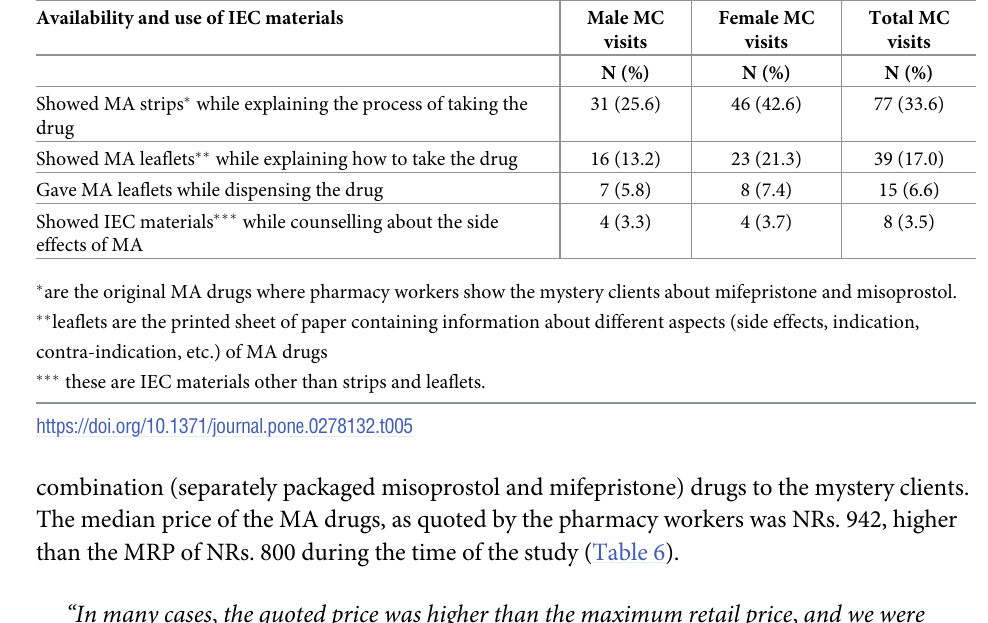
combination (separately packaged misoprostol and mifepristone) drugs to the mystery clients.